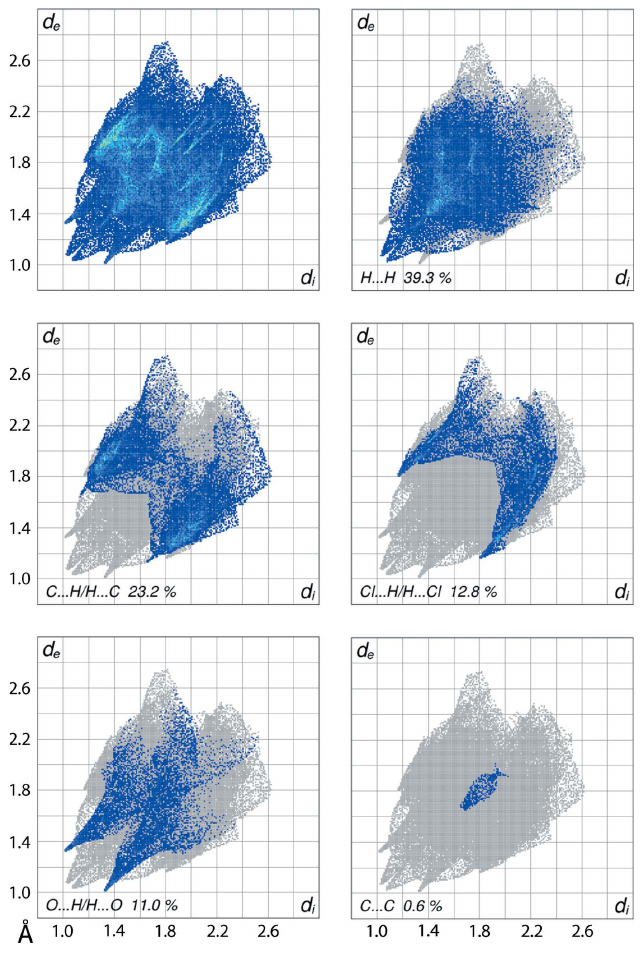
Figure 6 The full two-dimensional fingerprint plot for (I) and those delineated